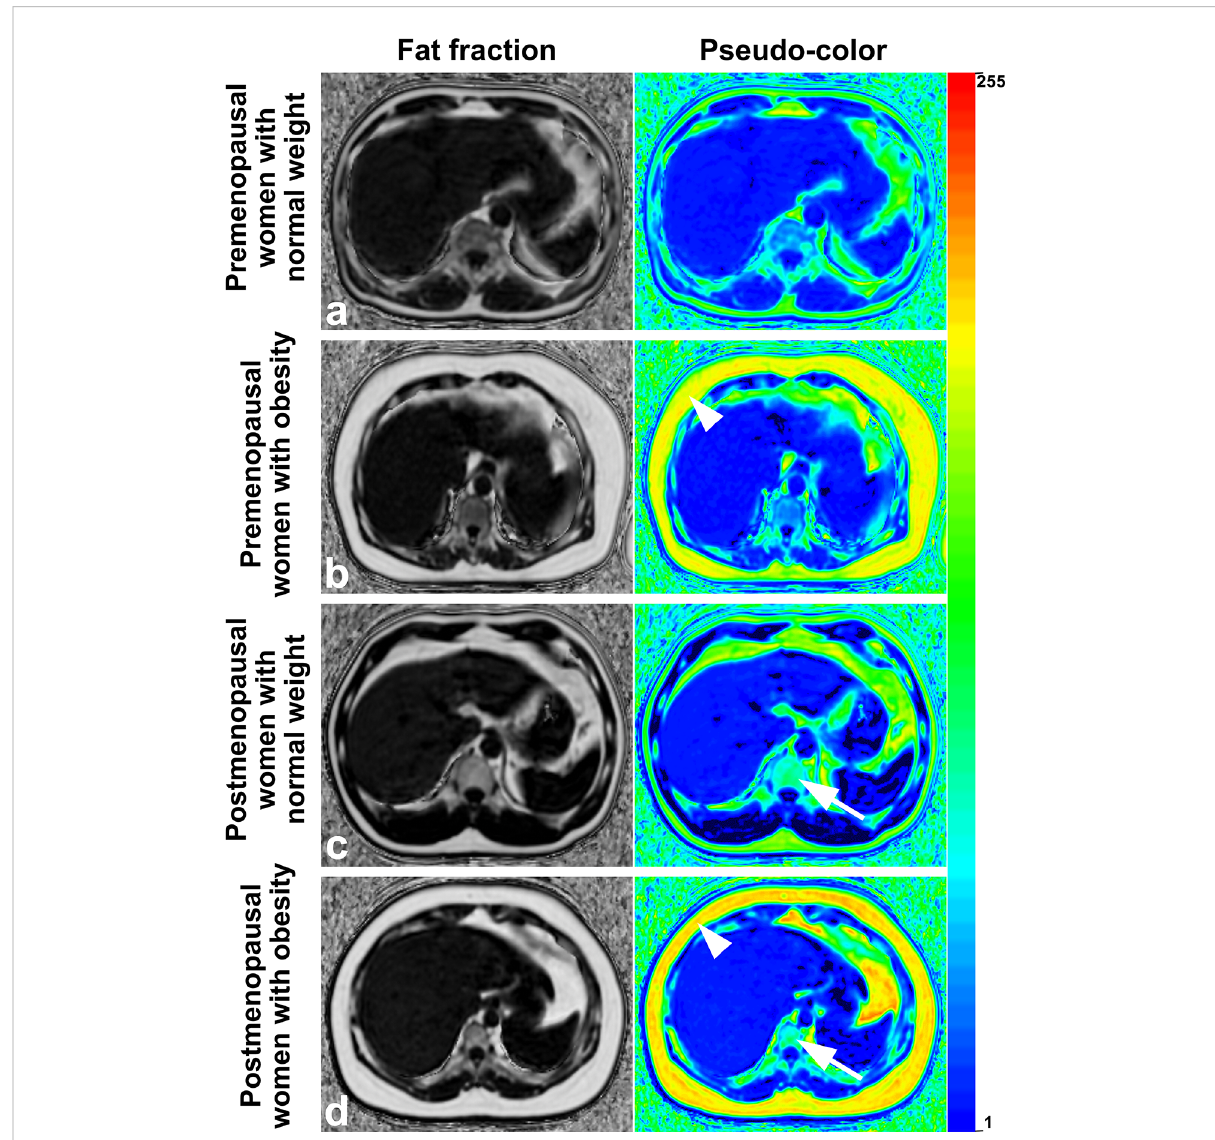
FIGURE 5 Images of premenopausal and postmenopausal women with obesity or normal weight patients (A) a 46 years old premenopausal woman with normal weight; (B) a 44 years old premenopausal woman with obesity; (C) a 53 years old postmenopausal woman with normal weight; and (D) a 56 years old postmenopausal woman with obesity). Fat deposition in subcutaneous sites (arrowheads) and lumbar vertebrae (arrows) was visible and was measured in the fraction map and pseudocolor images of the IDEAL-IQ sequence. Examples showed that fat deposition in the lumbar vertebra increased after menopause in both obese patients and normal-weight patients. IDEAL-IQ, iterative decomposition of water and fat with echo asymmetry and least-squares